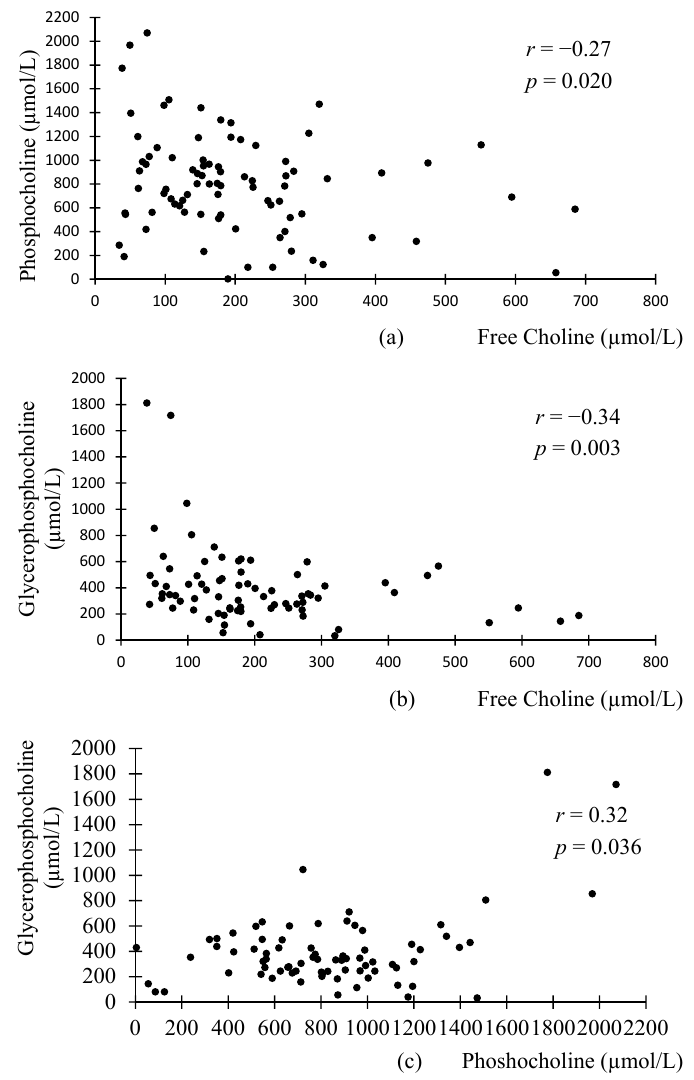
Figure 1. Scatterplots of the relationship between the different water-soluble choline compounds in preterm milk: ( a ) significant negative association between phosphocholine and free choline in preterm milk; ( b ) significant negative association between glycerophosphocholine and free choline in preterm milk; ( c ) significant positive association between glycerophosphocholine and phosphocholine in preterm milk. n = 75; associations were analyzed using Pearson’s